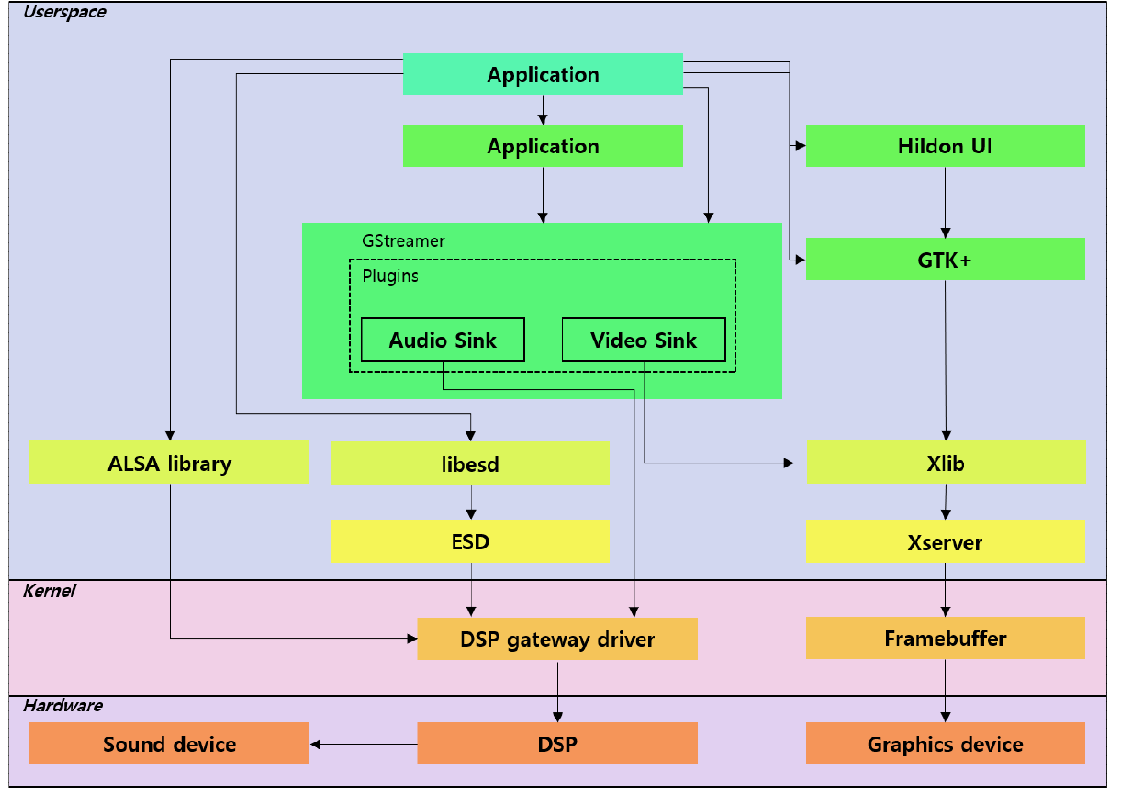
Figure 9. A multimedia architecture with